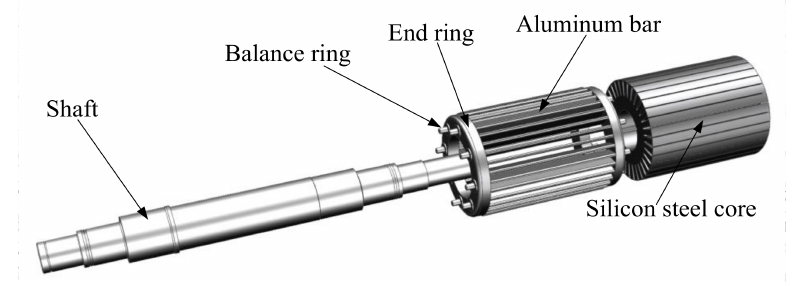
Figure 1. Squirrel cage rotor exploded diagram.